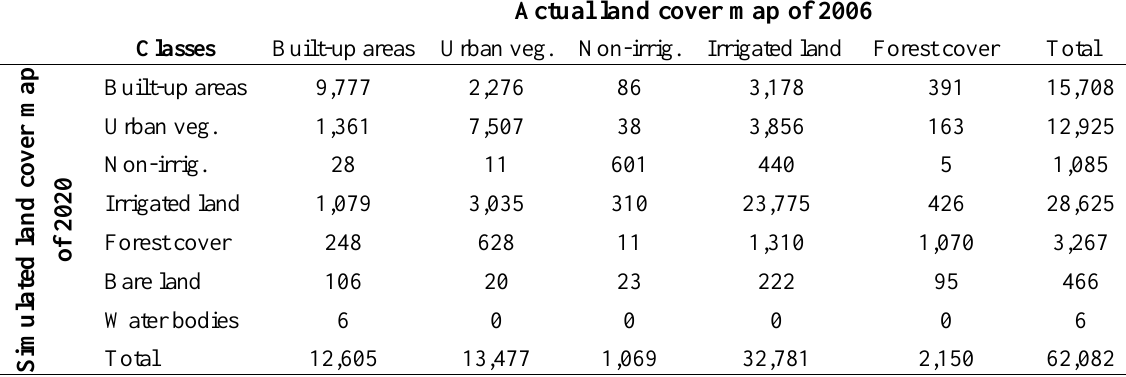
Table 7. Cross-tabulation of actual land cover in 2006 with simulated land cover for 2020 (number of